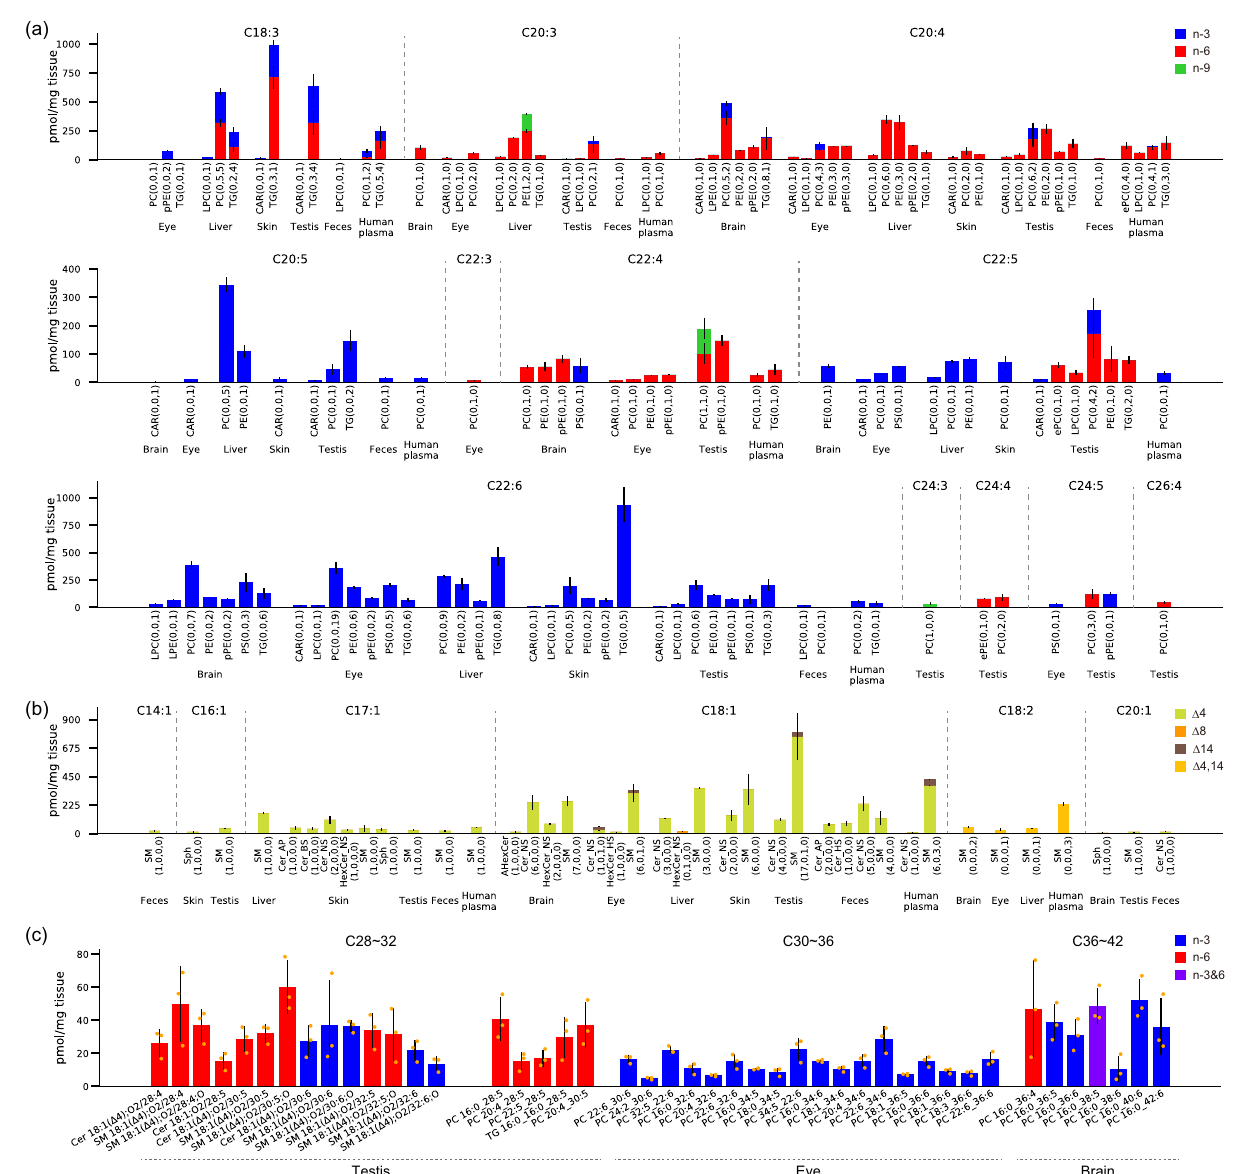
Fig. 5 Lipidome pro fi les of C = C positional isomers in PUFAs, sphingoid bases, and very long chain-polyunsaturated fatty acids (VLC-PUFAs). a The detailed pro fi le of PUFA from C18:3 to C26:4. The numbers in the bracket show the count of annotated lipids for n-9, n-6, and n-3 positional isomers: e.g. PC (0,6,2) means that zero, six, and two lipid molecules of n-9, n-6, and n-3 were characterized, respectively. b The detailed pro fi le of sphingolipids containing SPB 14:1;O2, SPB 16:1;O2, SPB 17:1;O2, SPB 18:1;O2, SPB 18:2;O2 and SPB 20:1;O2. The numbers in the bracket show the count of annotated lipids for Δ 4, Δ 8, Δ 14, and Δ 4,14 positional isomers: e.g. SM (6,0,1,0) means that six, zero, one, and zero lipid molecules of Δ 4, Δ 8, Δ 14, and Δ 4,14 were characterized, respectively. The error bar indicates the standard deviation (SD, n = 3). For human plasma, the y -axis unit becomes pmol/ µ L plasma instead of pmol/mg tissue. c The pro fi le of VLC-PUFAs in O - and N -acyl chains ranging C28:4 to C42:6. The error bar indicates SD ( n = 3). PC 16:0_38:5(n-3&6) indicated the ambiguous annotation of PC 16:0_38:5(n-3,6,9,12,15) and PC